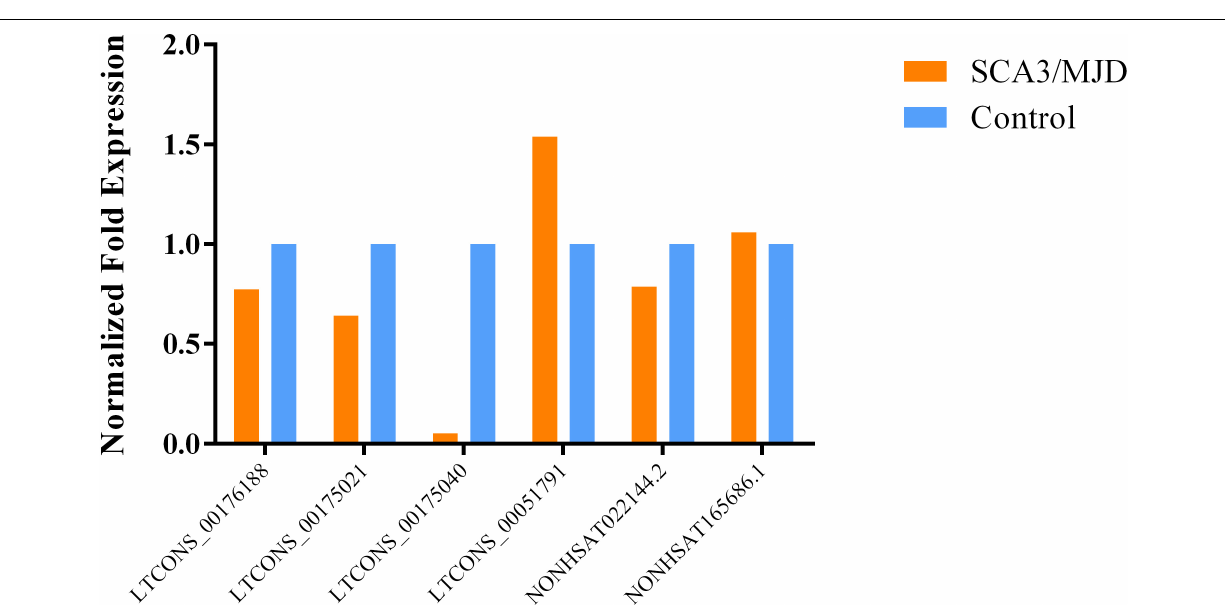
FIGURE 6 | The expression level of statistically significant DEGs in cerebellum tissue. The expression levels of LTCONS_00176188 and NONHSAT022144.2 decreased by about a quarter in the cerebellar tissues of SCA3/MJD patients, while the expression levels of LTCONS_00175021 decreased by about a third in the cerebellar tissues of SCA3/MJD patients, Surprisingly, the expression of LTCONS_00175040 is only 5% of the control. Among the up-regulated genes, the expression level of NONHSAT165686.1 was only 5% higher than that of the control group, while the expression level of LTCONS_00051791 was 1.5 times that of the control